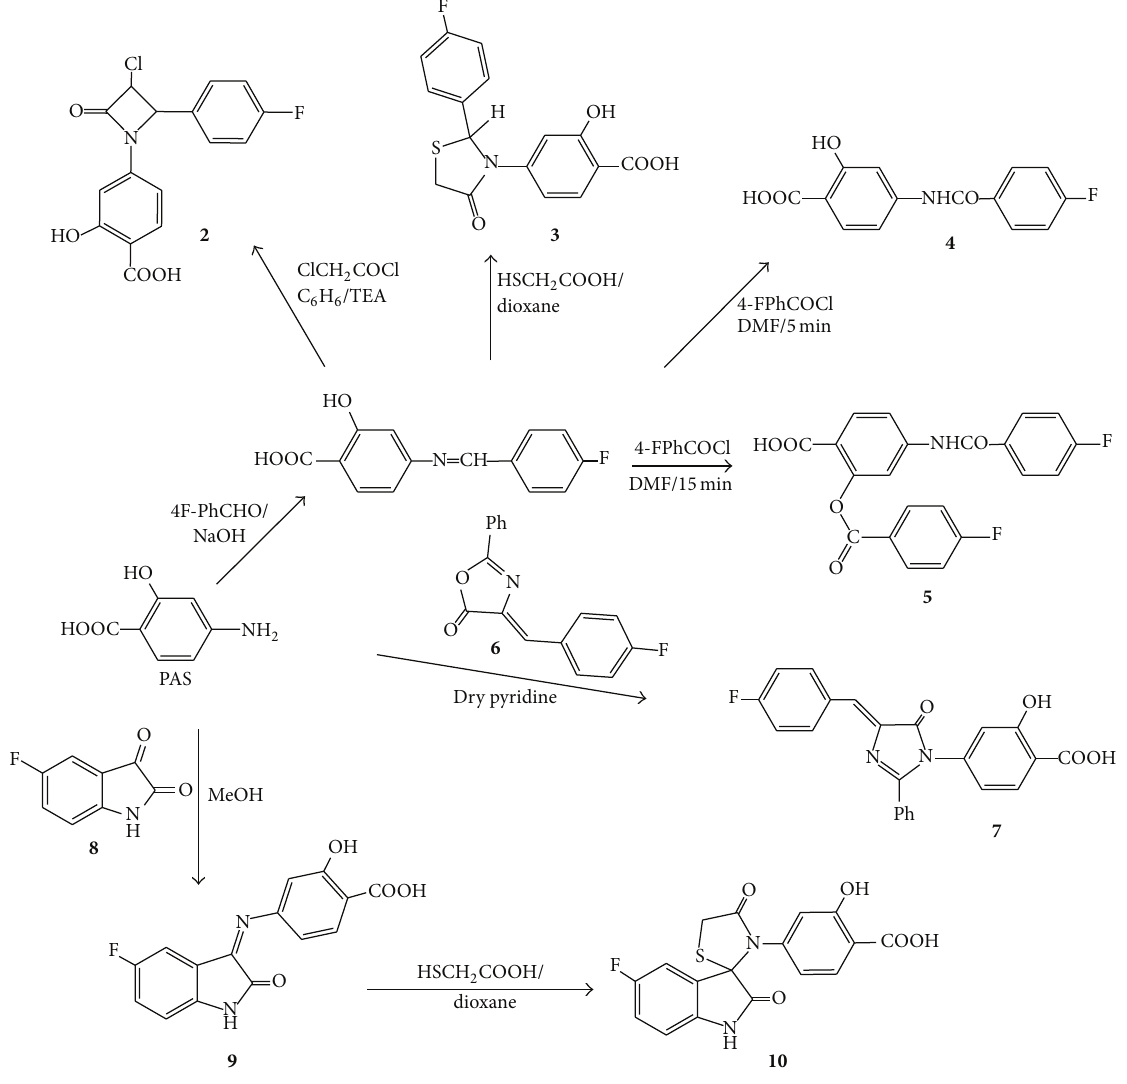
cooled and poured onto ice. The precipitated solid was filtered and recrystallized from THF to give 5 as yellow crystals